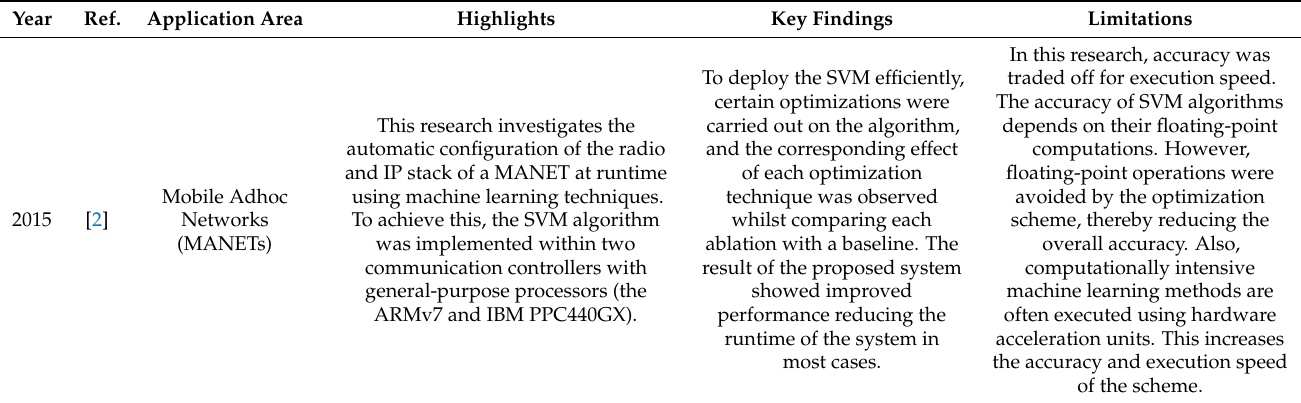
Table 18. Intelligent sensor systems and